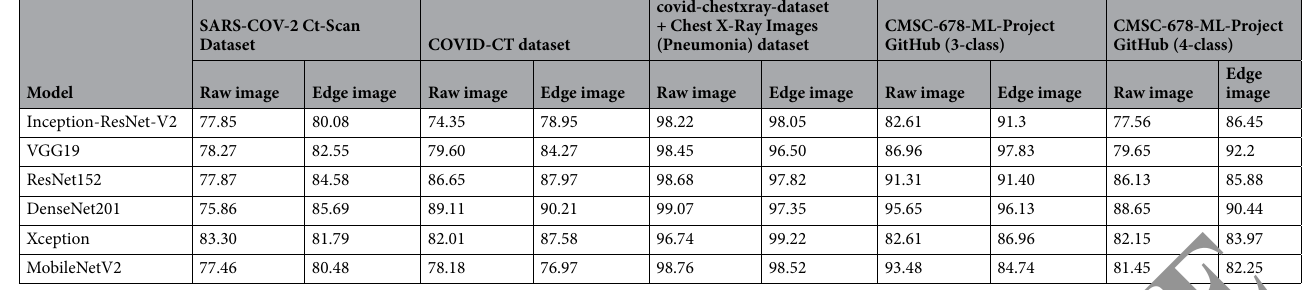
Table 3. Accuracies(%) obtained by applying Inception-ResNet-V2, VGG19, ResNet152, DenseNet201, Xception, MobileNetV2 models for both raw and edge-mapped images.